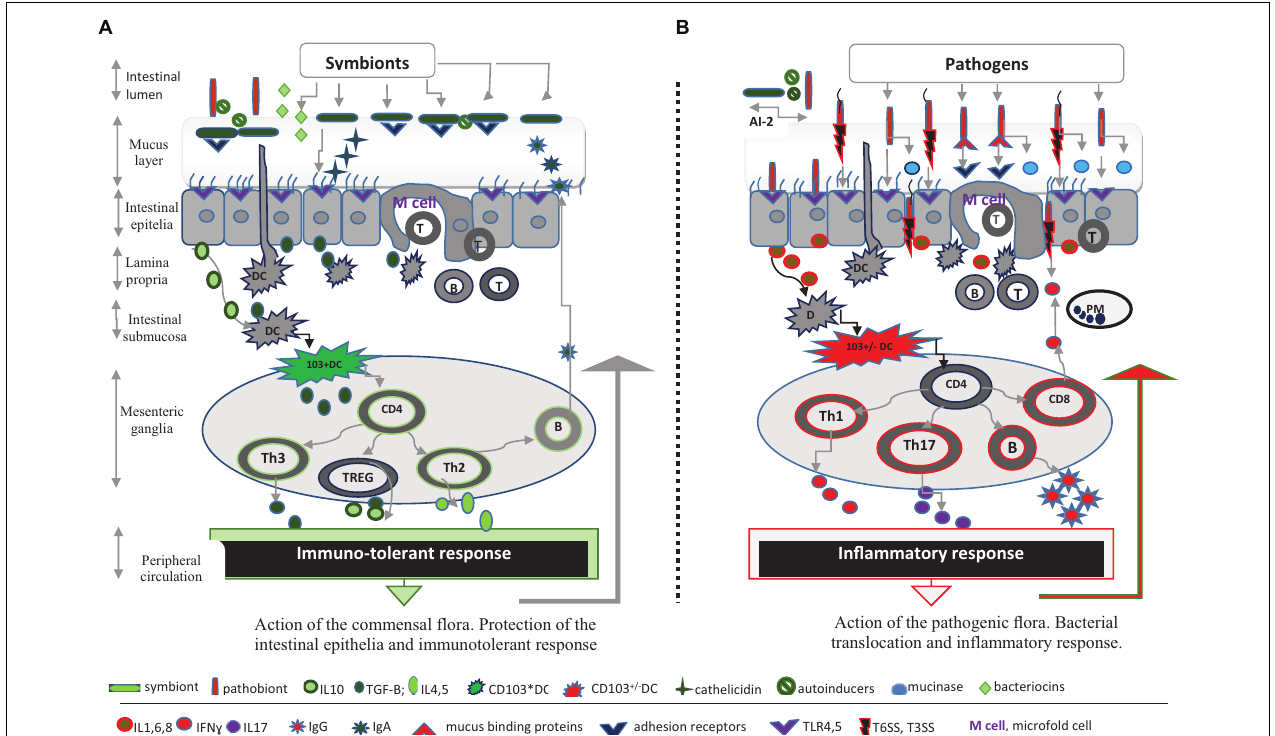
FIGURE 1 | Microbiota and the intestinal barrier against infectious threats. (A) Symbionts shape mucosal immunity and protect intestinal epithelia. The commensal flora, intestinal epithelia covered by mucus, and the mucosal immune response form a complex intestinal barrier against infectious threats. The first line of defense is represented by the mucus layer as well as by antimicrobial peptides (cathelicidin), bacteriocins, and intestinal IgA that ensure the integrity of intestinal epithelial cells (IECs). The commensal flora is interconnected through Quorum-sensing signals (e.g., AI-2 inducer) and is anchored to the protective mucus, at a distance from the intestinal epithelia. Thus commensal species reach high densities in mucosal niches and use available nutrient sources contributing to the colonization resistance. The mucosal immunity is best represented by a network of cells and cytokines within the lamina propria, submucosa and mesenteric ganglia that are ultimately modulated by the commensal flora. Commensals activate resident submucosal dendritic cells (DCs) and initiate an immunosuppressive response through NFkB/TGF β pathway which in turn activates the lymphnode CD103 + DCs mesenteric population. These DCs subset have the ability to prime naïve CD4+ T cell lymphocytes from mesenteric ganglia and induce immunosuppressive CD4+ T cells lineages, namely Th3, FoxP3+ (TREG) and Th2-inducing IL10, and TGF- β cytokines. The immune-tolerant response protects IECs and allows symbiotic relationships between the organism and commensal flora. (B) Intestinal pathogens activate inflammatory mediators and promote invasion. Pathogenic species possess virulence factors (T6SS or T3SS system, flagella, mucus binding proteins, mucinases, etc.) that enable their mucus diffusion and translocation across IECs. Herein pathogens activate TLR4 and 5 receptors and subsequently induce the release of inflammatory cytokines, IL1, IL6, and IL8. These cytokines further activate the CD103+/-DCs population and either promote CD4 T helper cells polarization into inflammatory Th1, Th17, and CD8-cytotoxic subsets or stimulate B lymphocytes to express IgG, while also reducing the immunosuppressive response. The IgG activity and inflammatory response driven by Th1/Th17-related cytokines, IFN- γ , IL-17, limits the bacterial invasion. The AI-2 inducer produced by certain symbionts can also prevent intestinal colonization with pathogenic species through negative feedback signals. However a significant gut inflammatory response allows bacterial